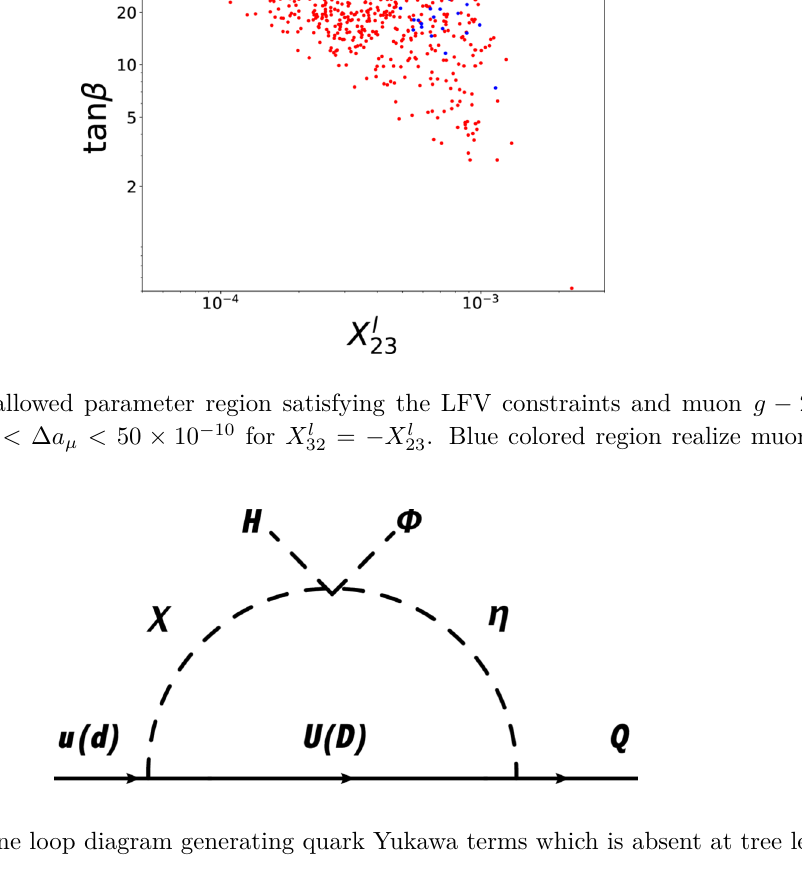
Figure 10 . One loop diagram generating quark Yukawa terms which is absent at tree